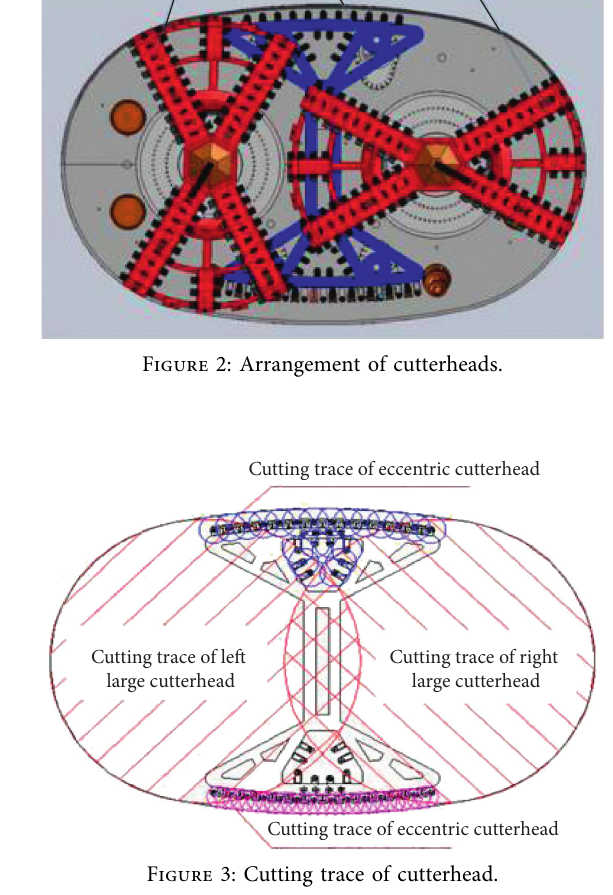
Cutting trace of eccentric Figure 3: